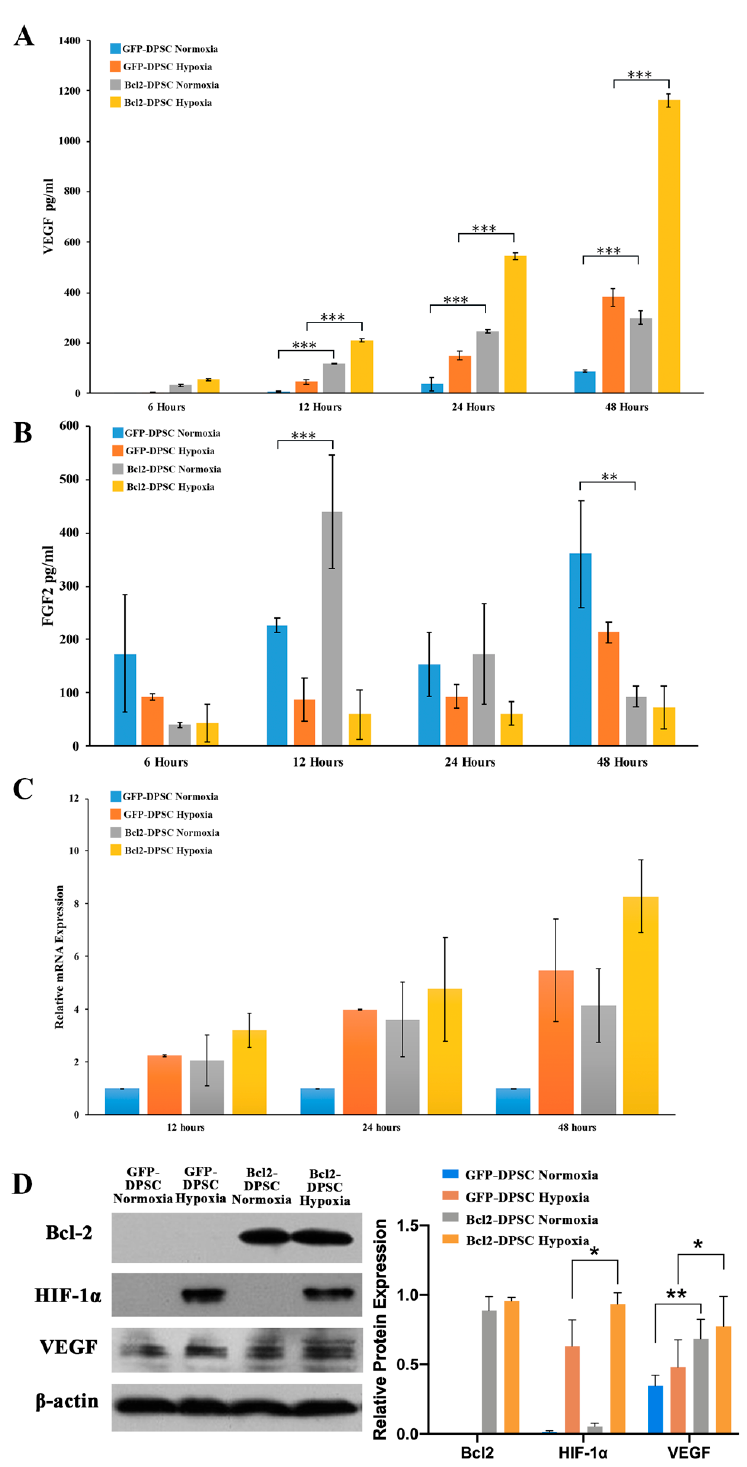
Figure 3. Expression of angiogenic factors in Bcl-2-DPSCs. Secretory ( A ) vascular endothelial growth factor (VEGF) and ( B ) fibroblast growth factor-2 (FGF2) levels at 6, 12, 24, and 48 h in Bcl-2-DPSCs and GFP-DPSCs under normoxia and hypoxia as detected by enzyme-linked immunosorbent assay (ELISA). ( C ) VEGF mRNA expression in Bcl-2-DPSCs and GFP-DPSCs under normoxia and hypoxia at 12, 24, and 48 h. ( D ) VEGF and hypoxia inducible factor (HIF)-1 α protein levels at 24 h in Bcl-2-DPSCs and GFP-DPSCs under normoxia and hypoxia. β -actin – endogenous control * p < 0.05, ** p < 0.01, *** p < 0.001 versus the corresponding